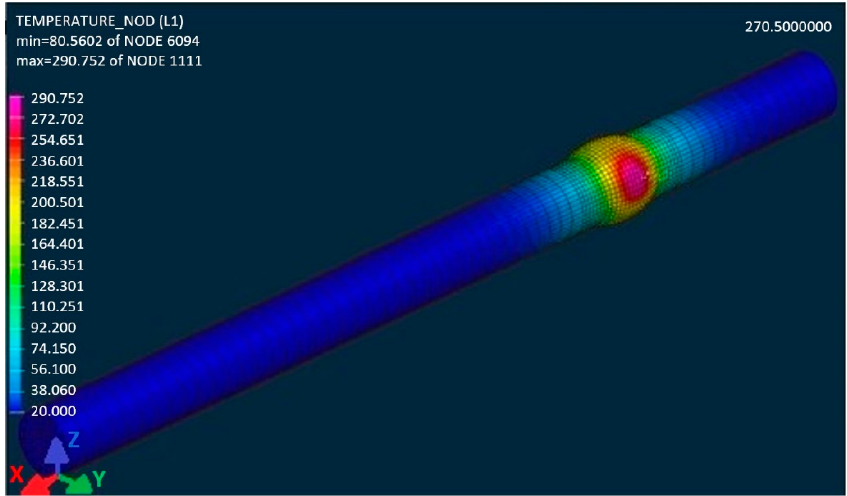
Figure 15. The simulation of the heat gradient of the material EN AW 6063.T66 welded by the TIG technology when implementing the predefined welding parameters for the period t = 0.5 s of the welding time.